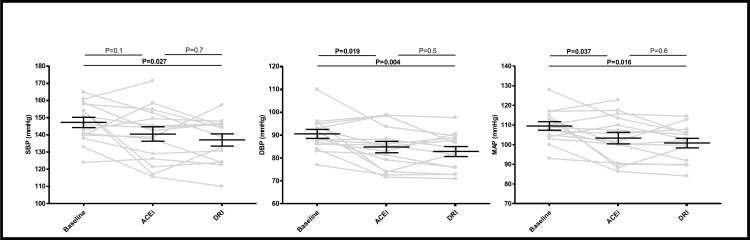
Blood pressure measured by ABPM at baseline and after 6-week treatment with ACEi and DRI.Individual data are shown as well as mean (SEM). ABPM measurement was unsuccessful in one patient during DRI treatment due to insufficient number of recordings (<80%). Abbreviations: SBP: systolic blood pressure; DBP: diastolic blood pressure; MAP: mean arterial pressure.